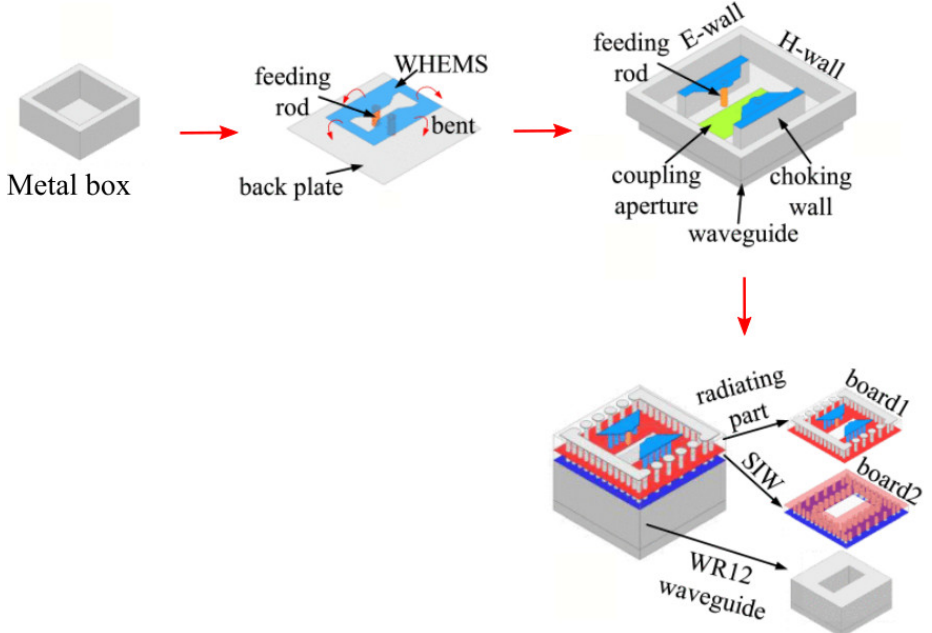
Figure 20. Design evolution of antenna in a package at 60 GHz presented in [107].